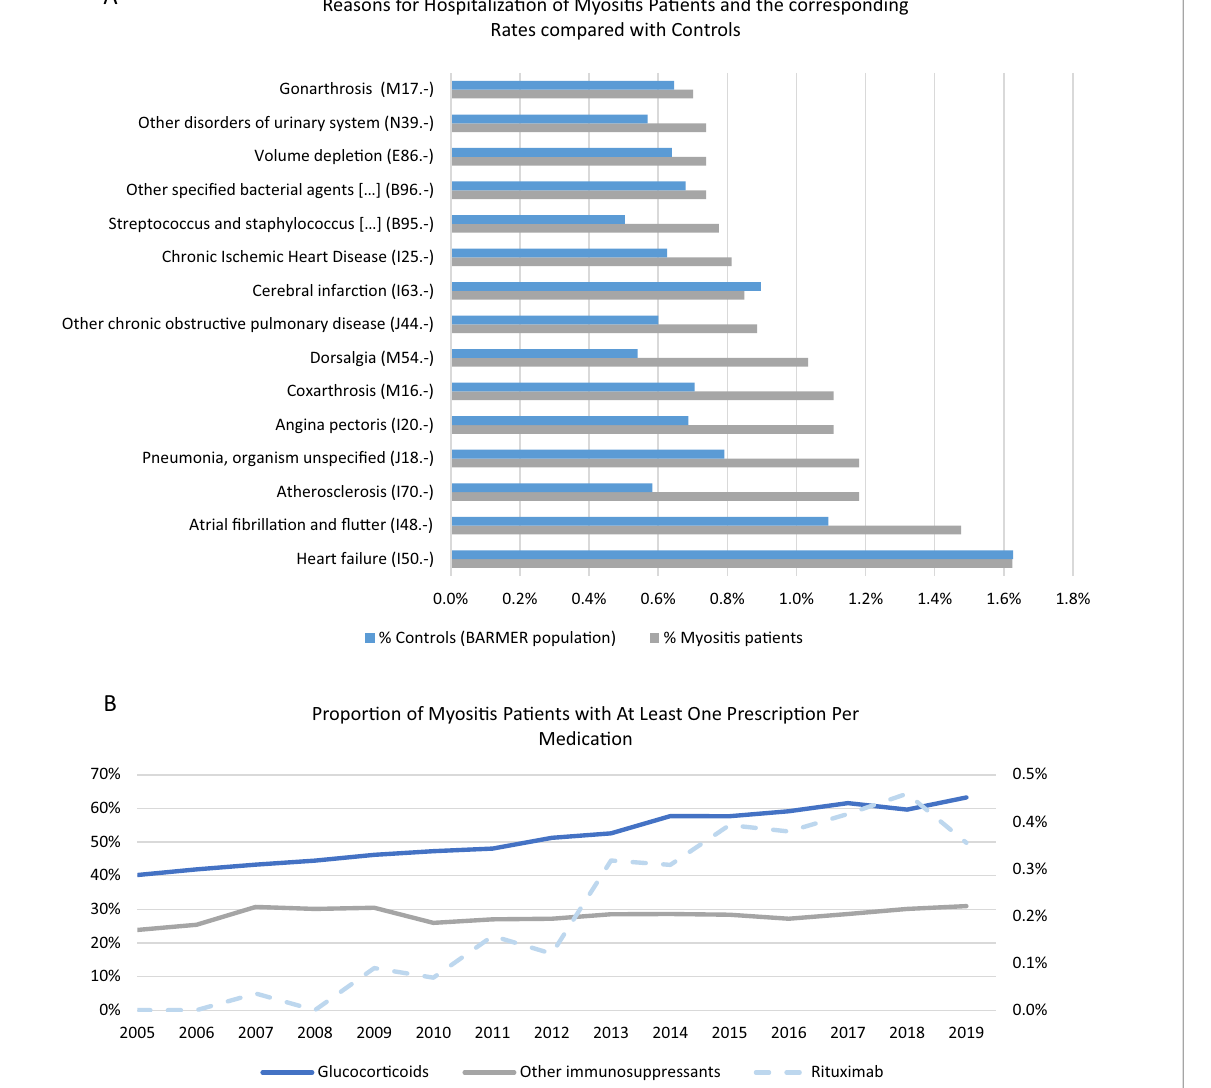
Fig. 4 Hospitalisation rate and treatment trends of myositis patients. A Analysis of the reasons for inpatient admission of myositis patients compared to the control group of the BARMER cohort (BARMER population) with relative frequencies. B Proportion of patients on glucocorticoid and other immunosuppressant therapy and/or rituximab therapy with at least one prescription per